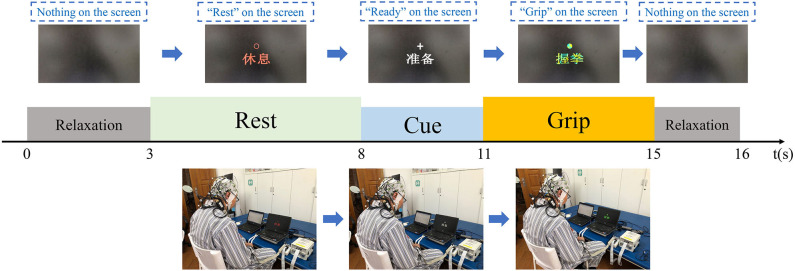
EEG evaluation paradigms. Each trial included a rest section, a ready section, a task section, and two relaxation sections.